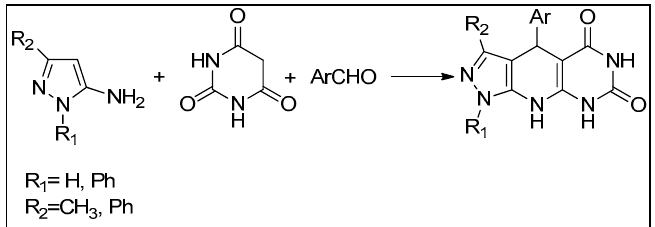
Figure 1. Synthesis of pyrazole based pyrido[2,3- d ]pyrimidine-diones [25,26].